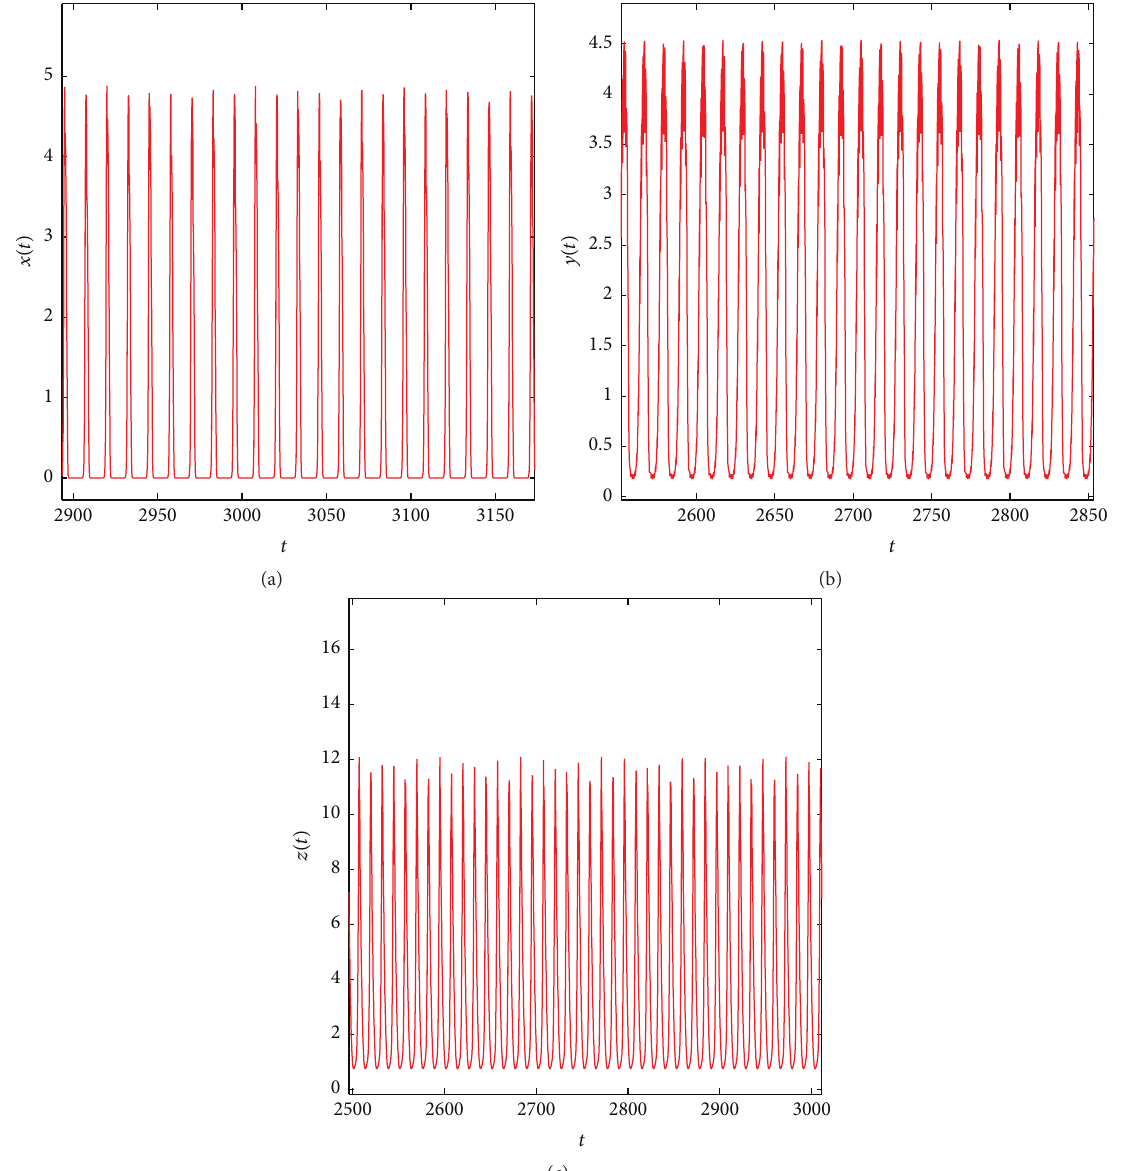
Figure 10: ((a) and (b)) Time series showing increased biomass densities 𝑥(𝑡) and 𝑦(𝑡) pest populations; (c) time series showing low biomass level of 𝑧(𝑡) population of system (2) with mixed Holling type II-III functional responses ( 𝑝 = 1 , 𝑞 = 1 , 𝑠 = 2 , and 𝑟 = 2 ) in presence of seasonal perturbation with data set (45) and 𝑃 = 0.1